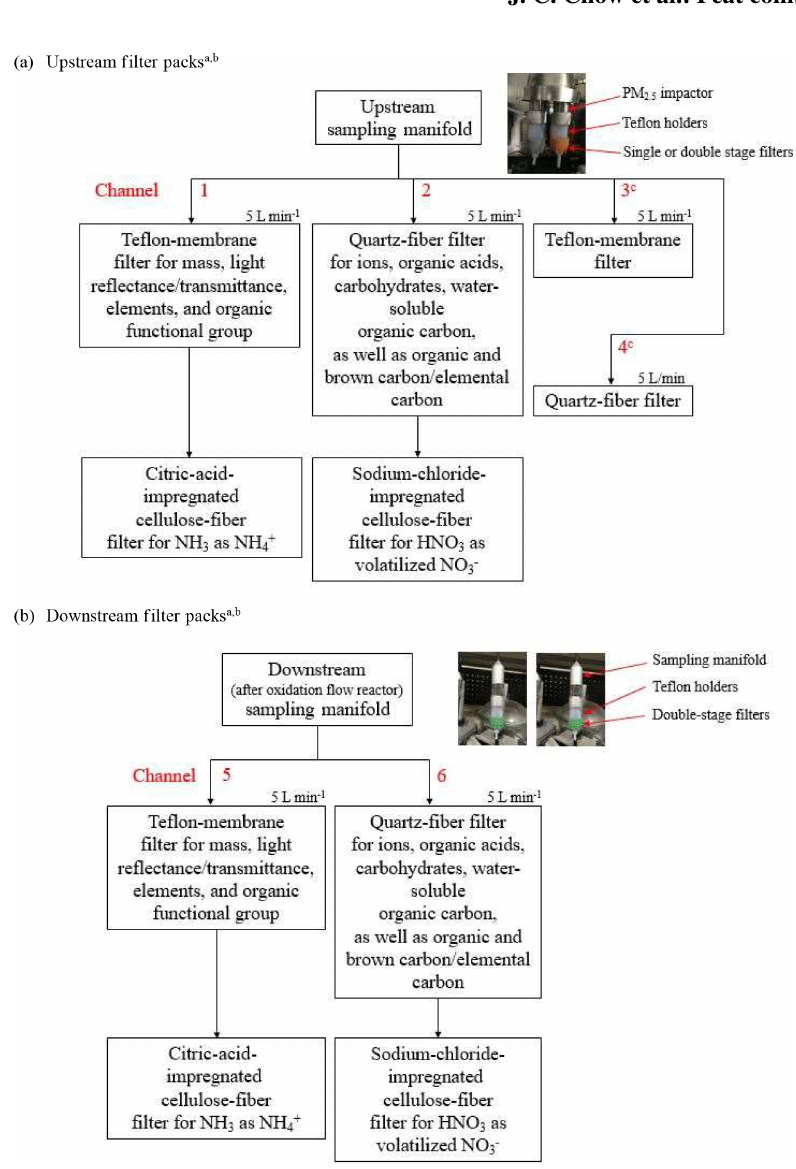
Figure 1. Filter pack sampling configurations for upstream and downstream channels of the oxidation flow reactor. a The filter types are (1) Teflon-membrane filter (Teflon©, 2µm pore size, R2PJ047, Pall Life Sciences, Port Washington, NY, USA); (2) quartz-fiber filters (Tis- suquartz, 2500 QAT-UP, Pall Life Sciences); and (3) citric-acid- and sodium-chloride-impregnated cellulose-fiber filters (31ET,